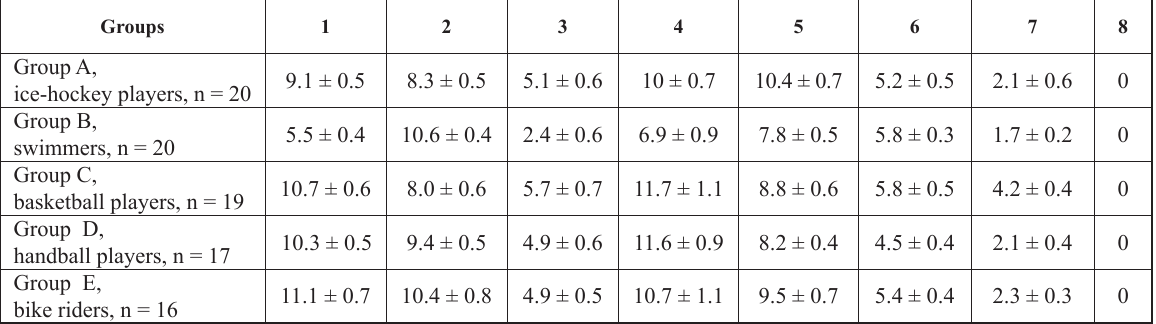
Table 1. Distance of the body points from the vertical line